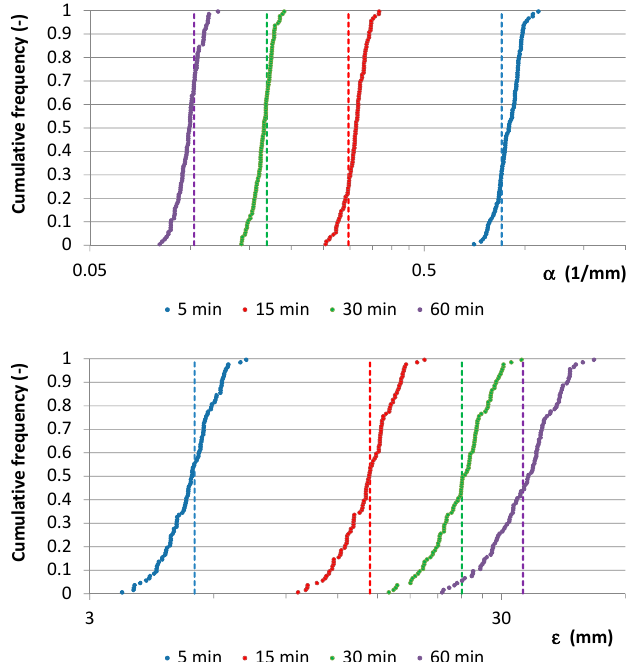
α ε ( top ) and ( bottom ). The